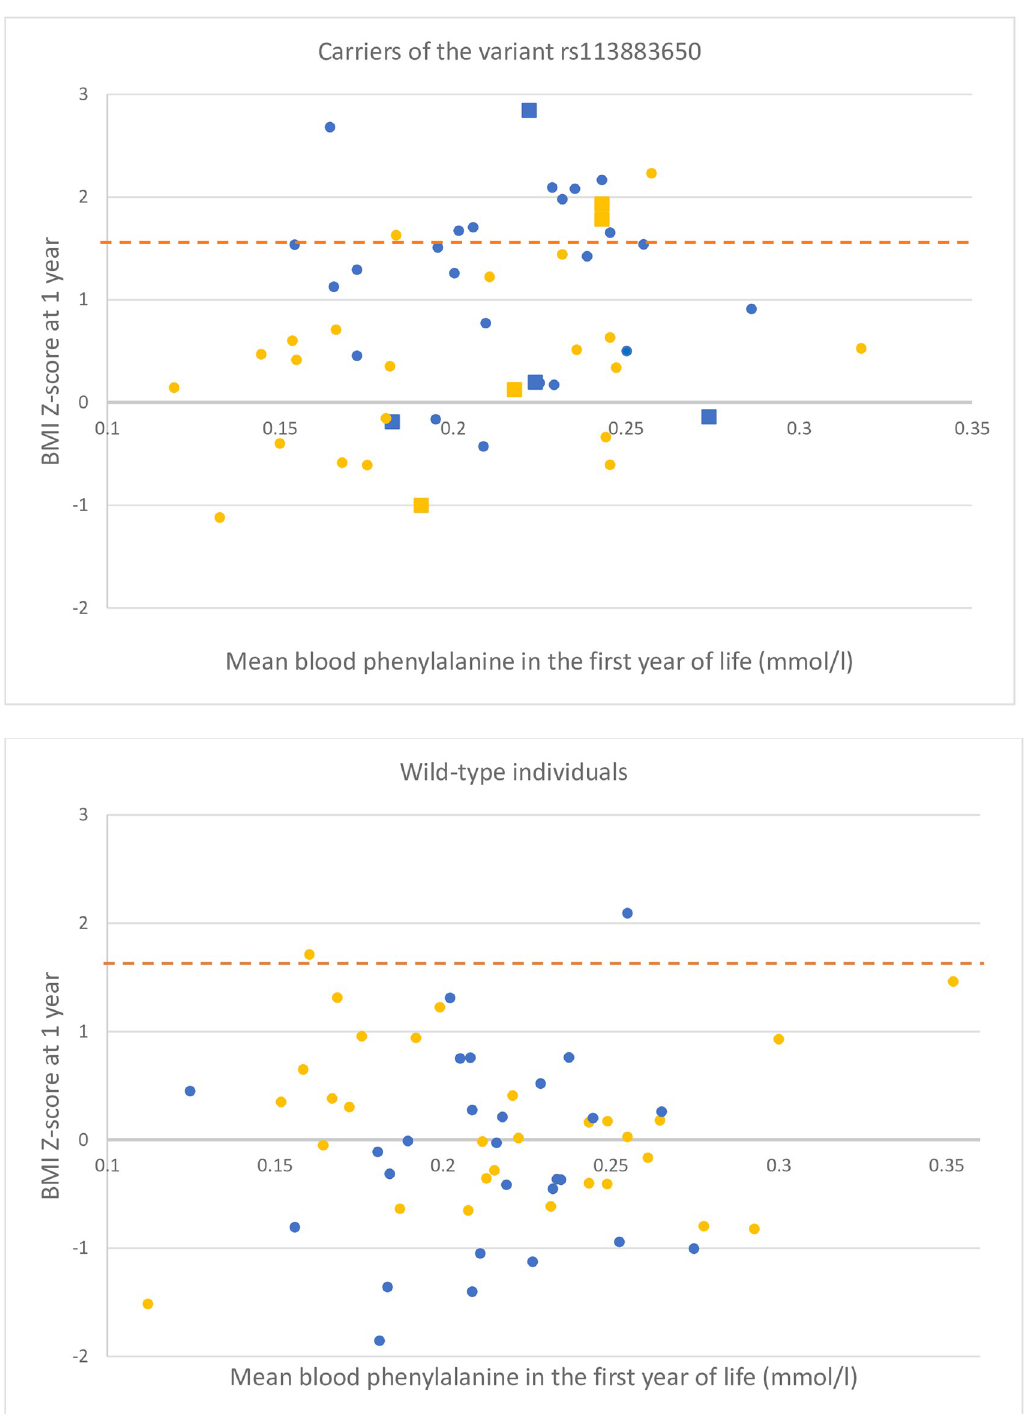
Fig 1. Differences in BMI Z-scores at one year for all infants with (the upper part of the figure) and without the rs113883650 variant of the LAT1 gene (the lower part of the figure), in the context of mean yearly blood phenylalanine concentrations. In patients with PKU, the mean BMI Z-score at one year reached +1.15 SD and -0.15 SD for the carriers of the LAT1 variant and wild-type individuals, respectively. The difference between both subgroups was highly significant (t(52) = 5.25, p = 0.00005). For the group of infants without diet, the mean BMI Z-score at one year reached 0.4 SD and 0.14 SD in carriers and wild-type individuals, respectively. The difference was not statistically significant (t(53) = 1.15, p = 0.25). Patients on dietary treatment